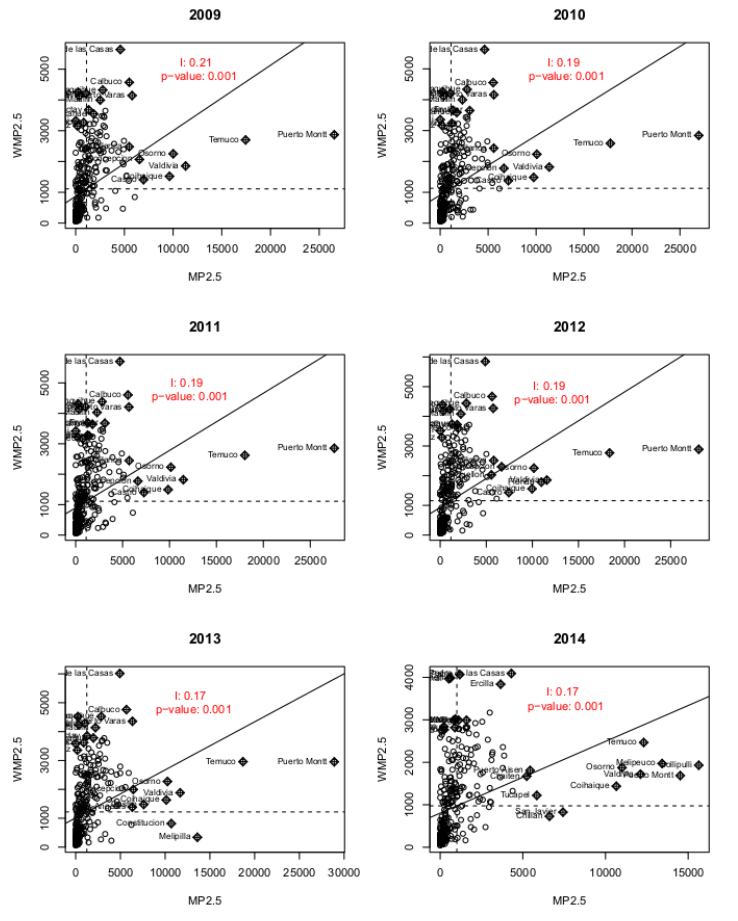
Figure 4: Moran’s scatterplots for average PM 2 . 5 emissions: Moran’s I test and p-value by